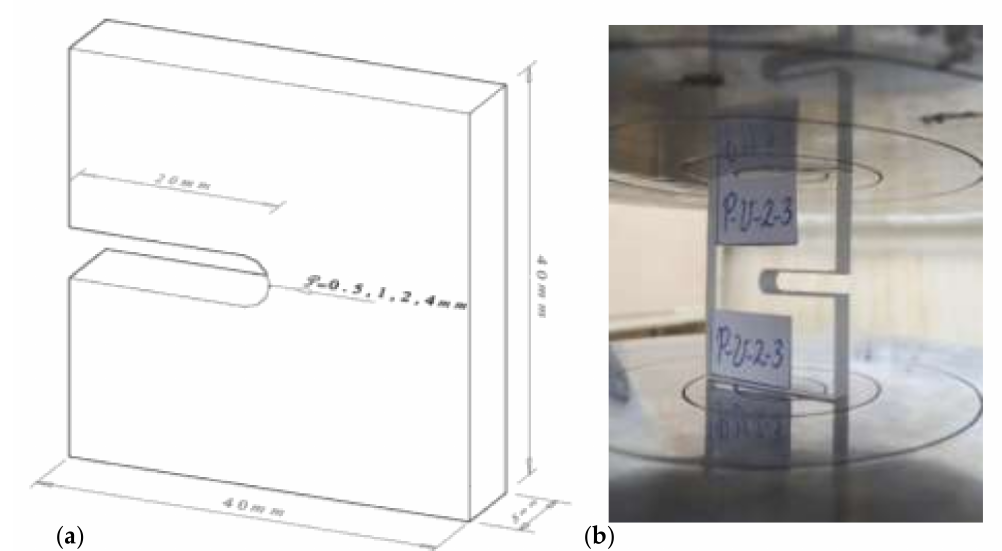
Figure 1. Fracture specimens tested under compressive loads: ( a ) geometry and dimensions; ( b ) example of Polymethyl-methacrylate (PMMA) specimen ( ρ = 2.0 mm) during the fracture